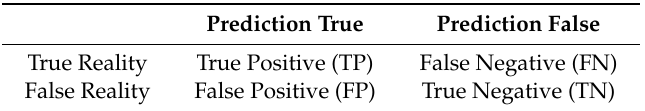
Table 2. Confusion